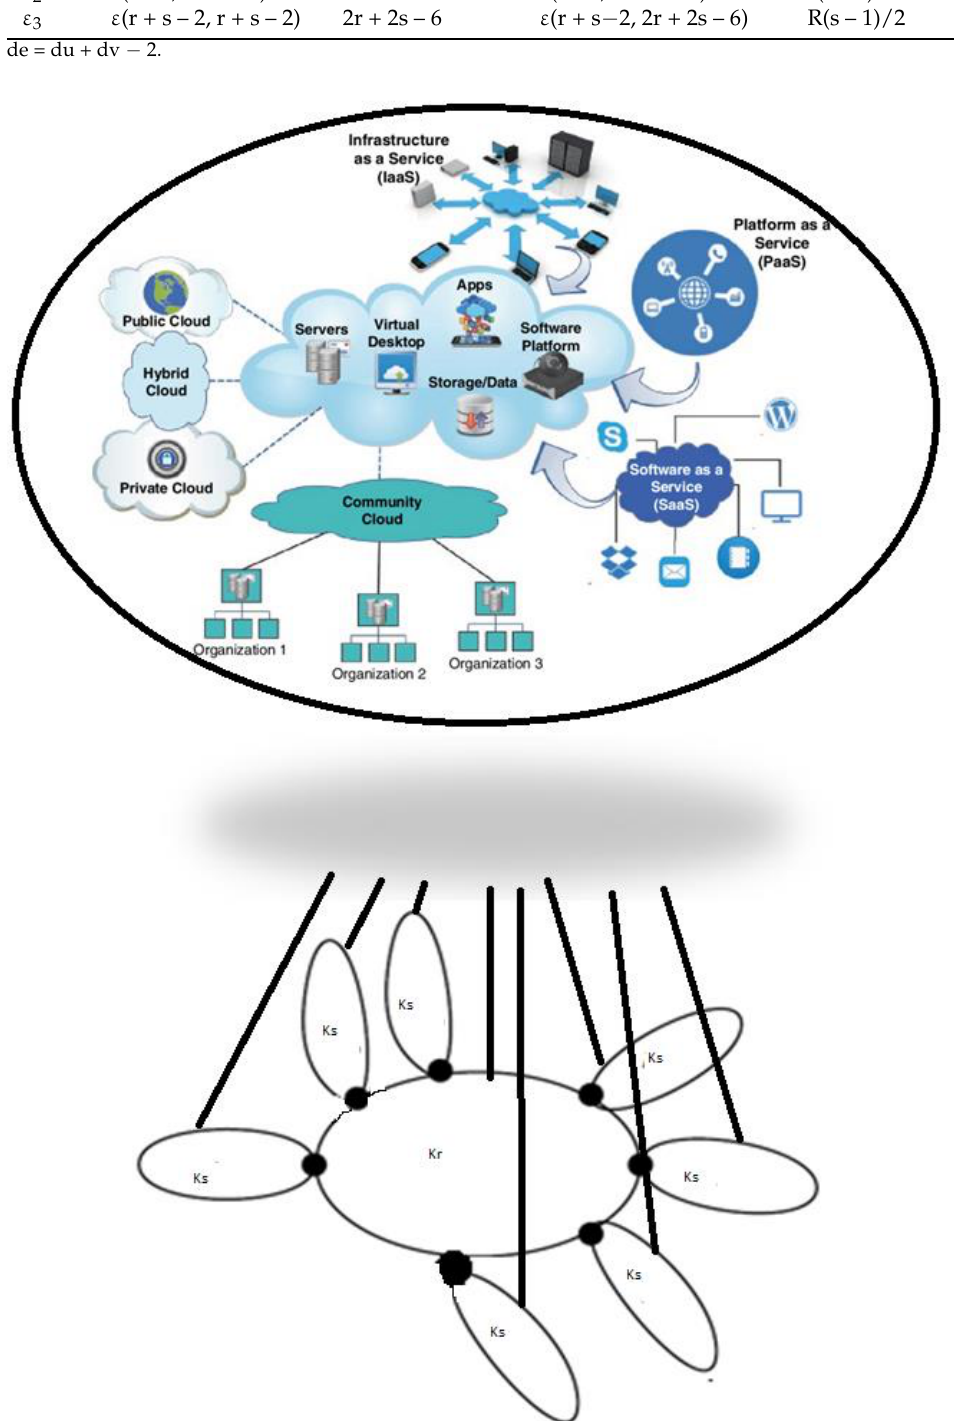
Figure 3. A cloud graph is extracted from a piece of a cloud computing network.